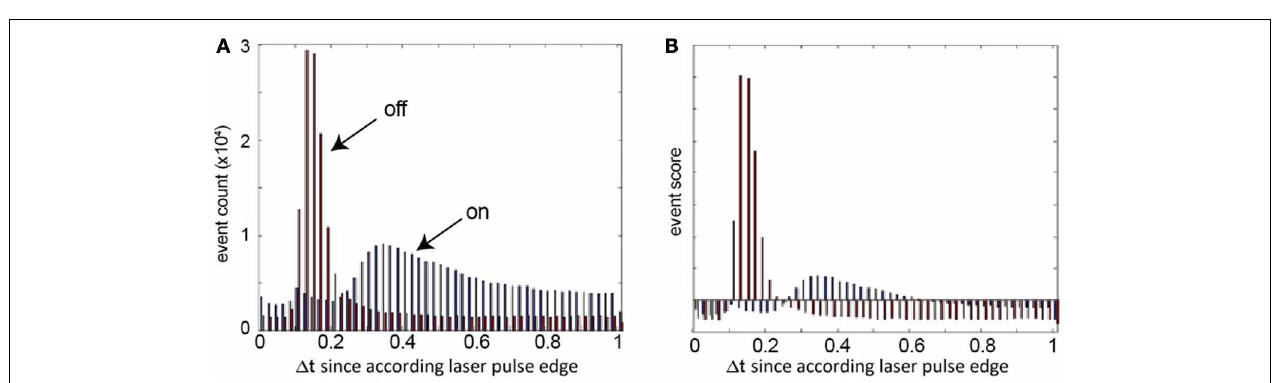
Frontiers in Neuroscience | Neuromorphic